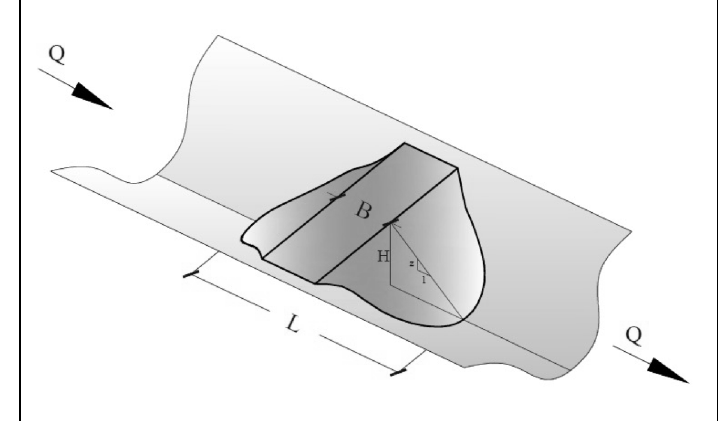
Figure 3 . Graphical view of rockfill dam